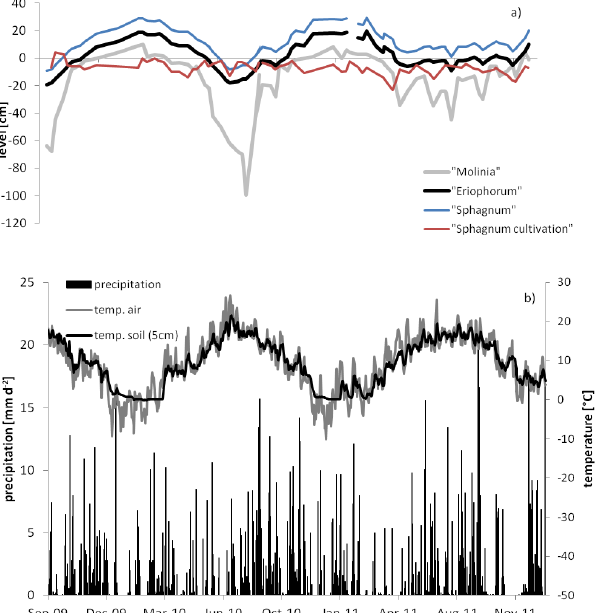
Figure 1. (a) Water level of the examination sites; (b) yearly devel- opment of temperatures and precipitation at the weather station near “ Sphagnum cultivation”, September 2009 until December 2011.